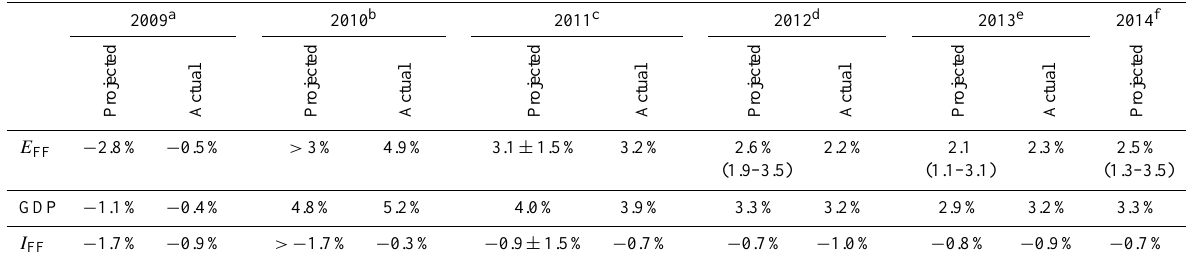
Table 9. Actual CO 2 emissions from fossil fuel combustion and cement production ( E FF ) compared to projections made the previous year based on world GDP (IMF October 2013) and the fossil fuel intensity of GDP ( I FF ) based on subtracting the CO 2 and GDP growth rates. The “Actual” values are the latest estimate available, and the “Projected” value for 2013 refers to those estimates presented in this paper. A correction for leap years is applied (Sect. 2.1.3).